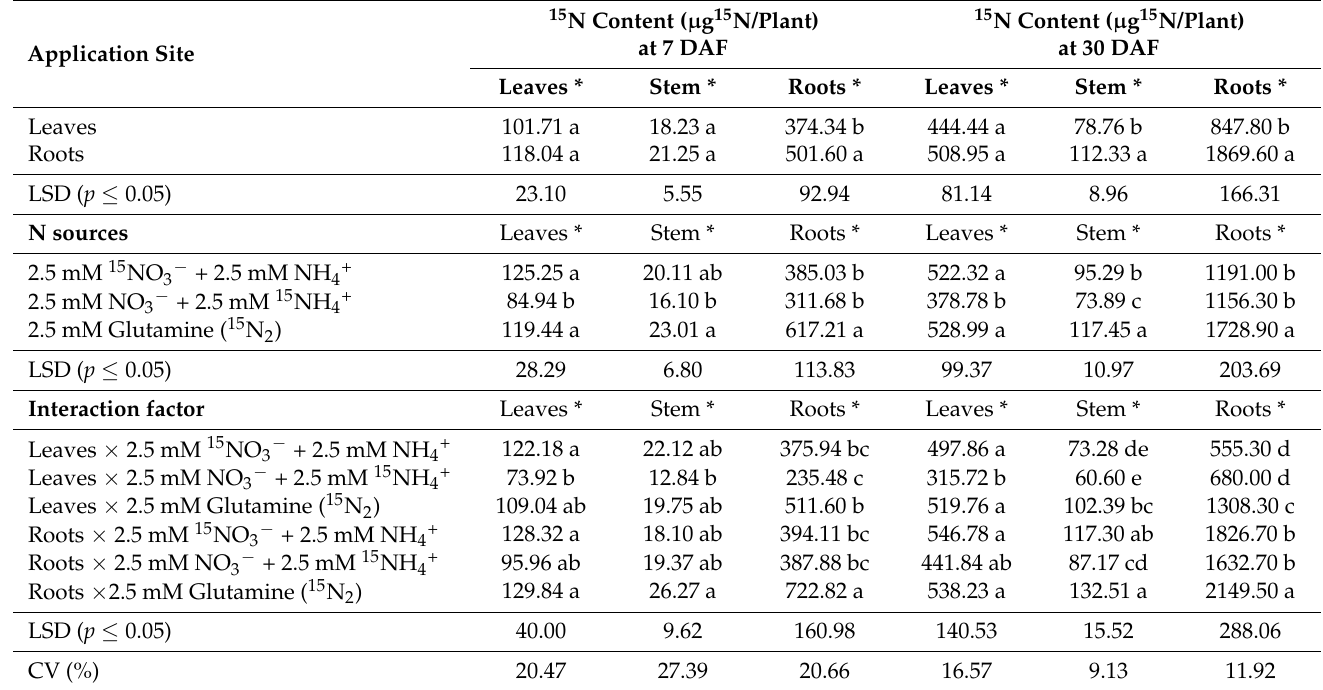
Table 2. N source and application site effect on labelled N content in Vanda ‘Patchara Delight’